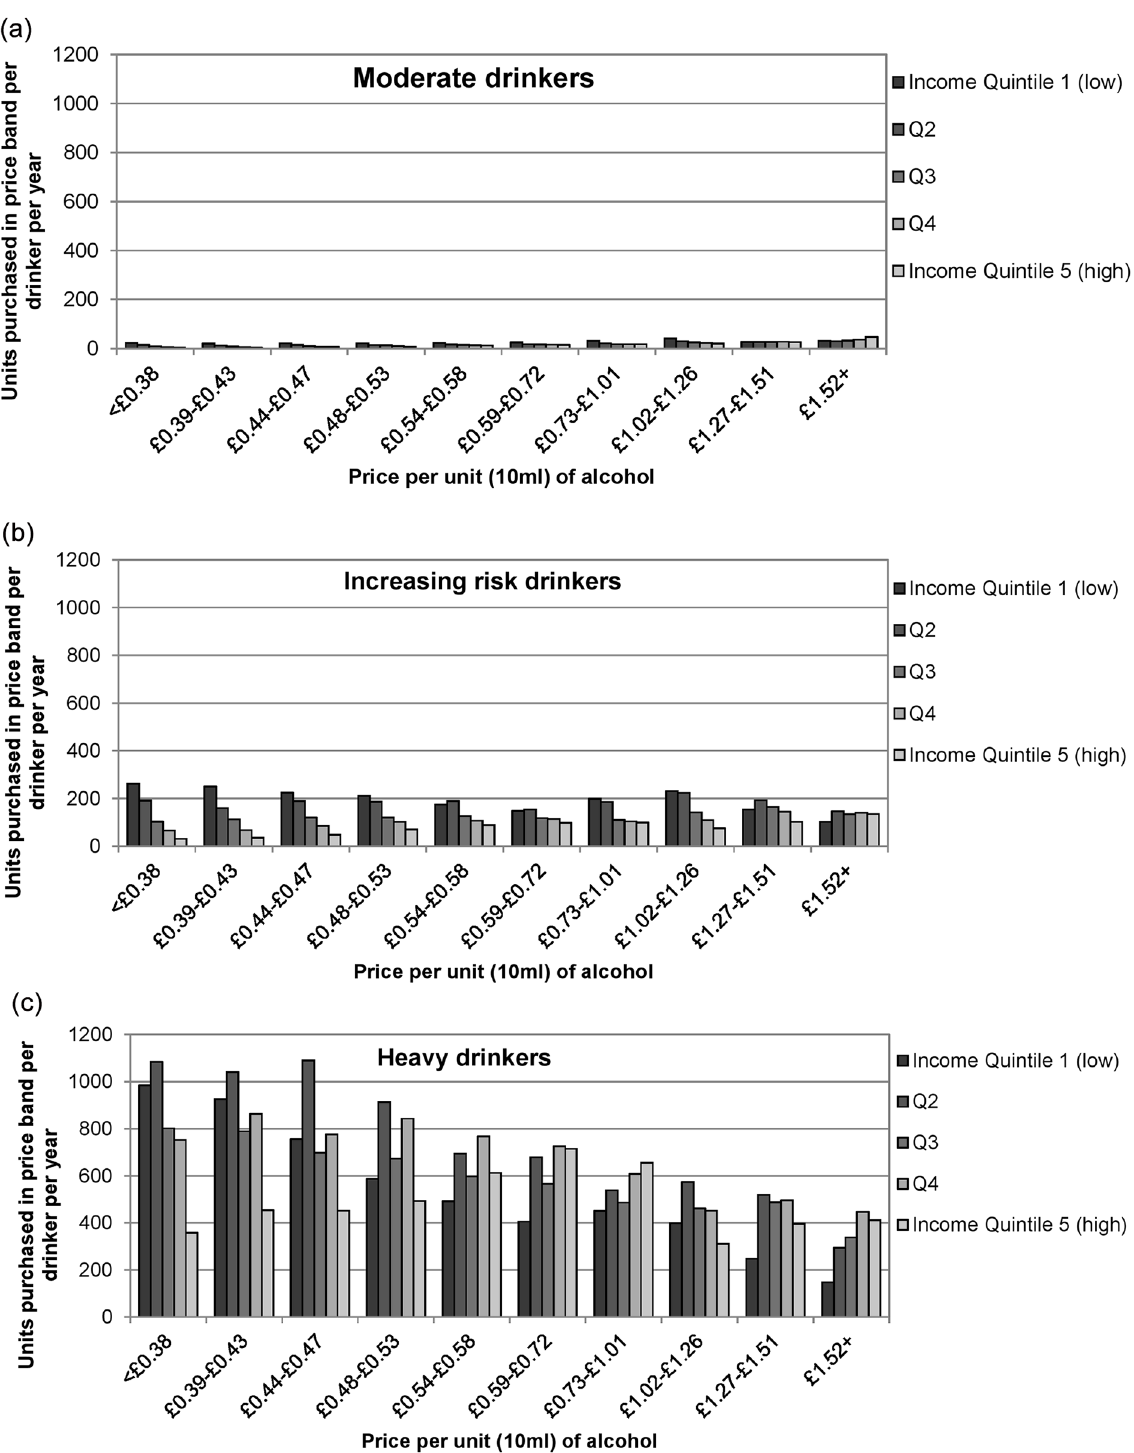
Fig 1. Distribution of alcohol purchasing by income. This figure shows the average number of units purchased per moderate drinker per year for alcohol across price bands, stratified by income. Moderate drinkers (a) purchase little alcohol overall and show a preference for middle and higher price bands, even when having lower incomes. Increasing risk drinkers (b) purchase alcohol across all price bands, but there is a clear gradient whereby poorer drinkers purchase more of the cheapest alcohol. Heavy drinkers (c) — across income quintiles, but especially poorer heavy drinkers — show a very clear preference for cheaper alcohol. Price bands are deciles of the price distribution of all alcohol sold in England. Income groups are defined by equivalised income